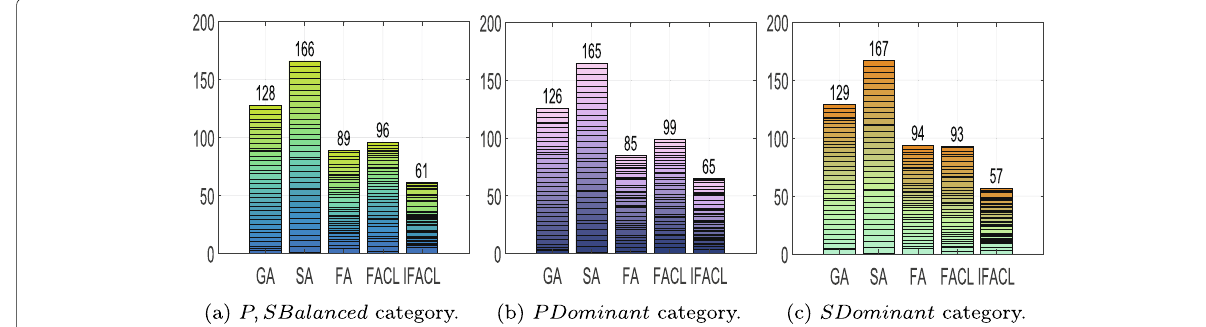
Fig. 3 Rank comparison of the five algorithms for Mean values over different categories on Dataset1